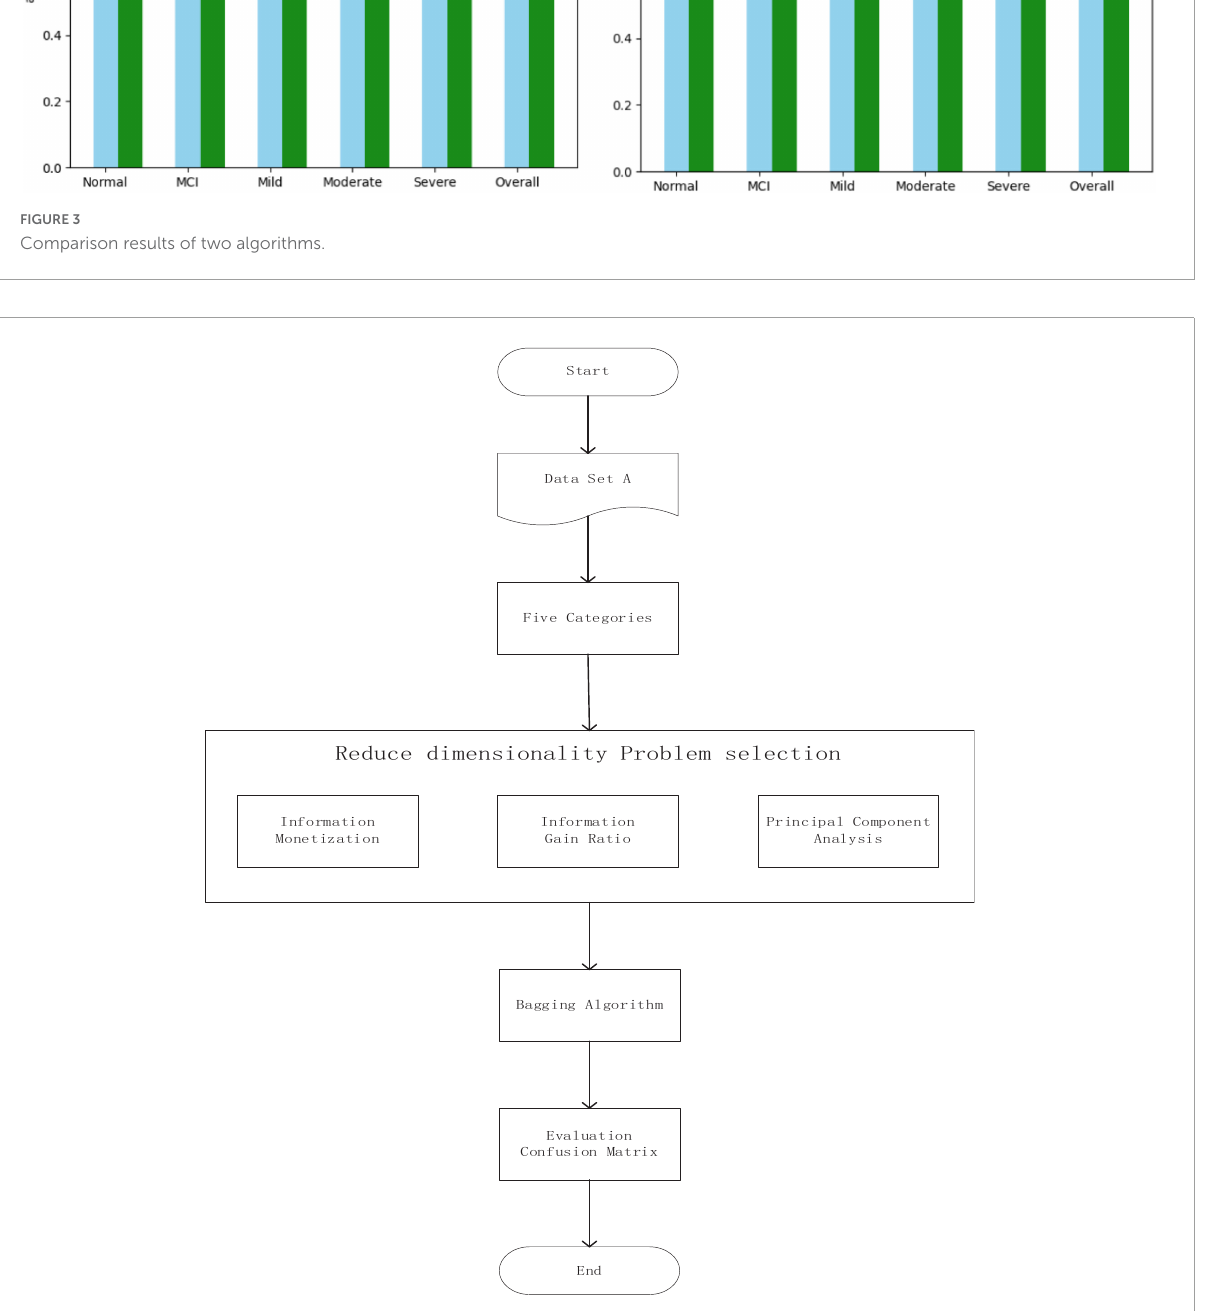
FIGURE3 Comparison results of two algorithms.